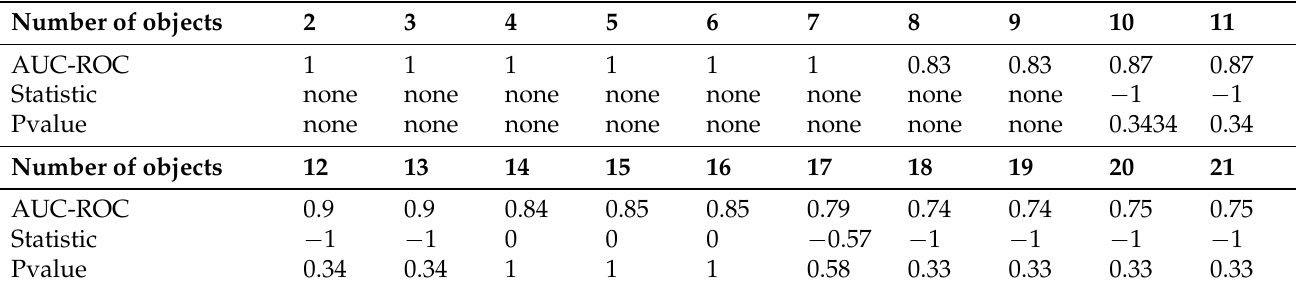
Table 7. An example of the quality of forecasting the trustworthiness of the counterparty using the constructed model. Number of